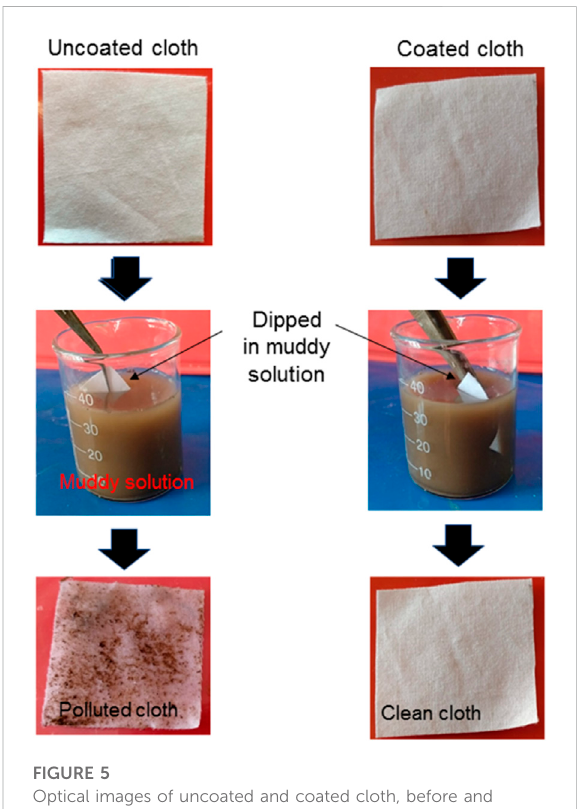
FIGURE 5 Optical images of uncoated and coated cloth, before and after immersing in the muddy solution, showing the ability of a coated cloth to sustain against the mud.